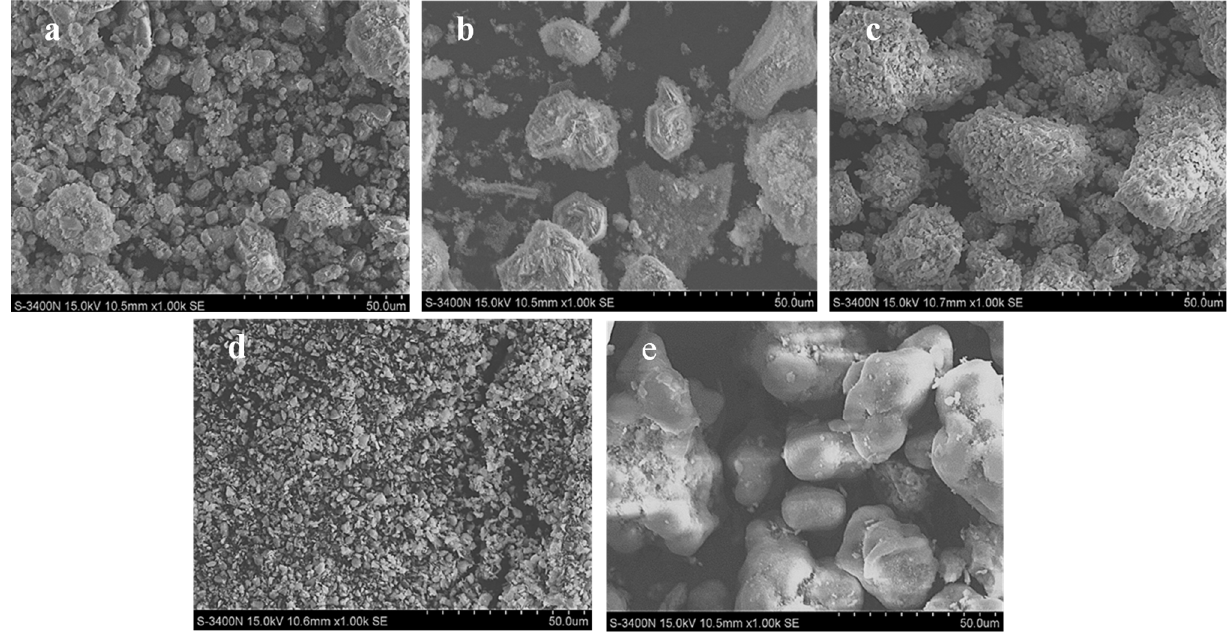
Figure 3. SEM images of ( a ) CP, ( b ) LP, ( c ) MP, ( d ) ALP, and ( e ) ZP.